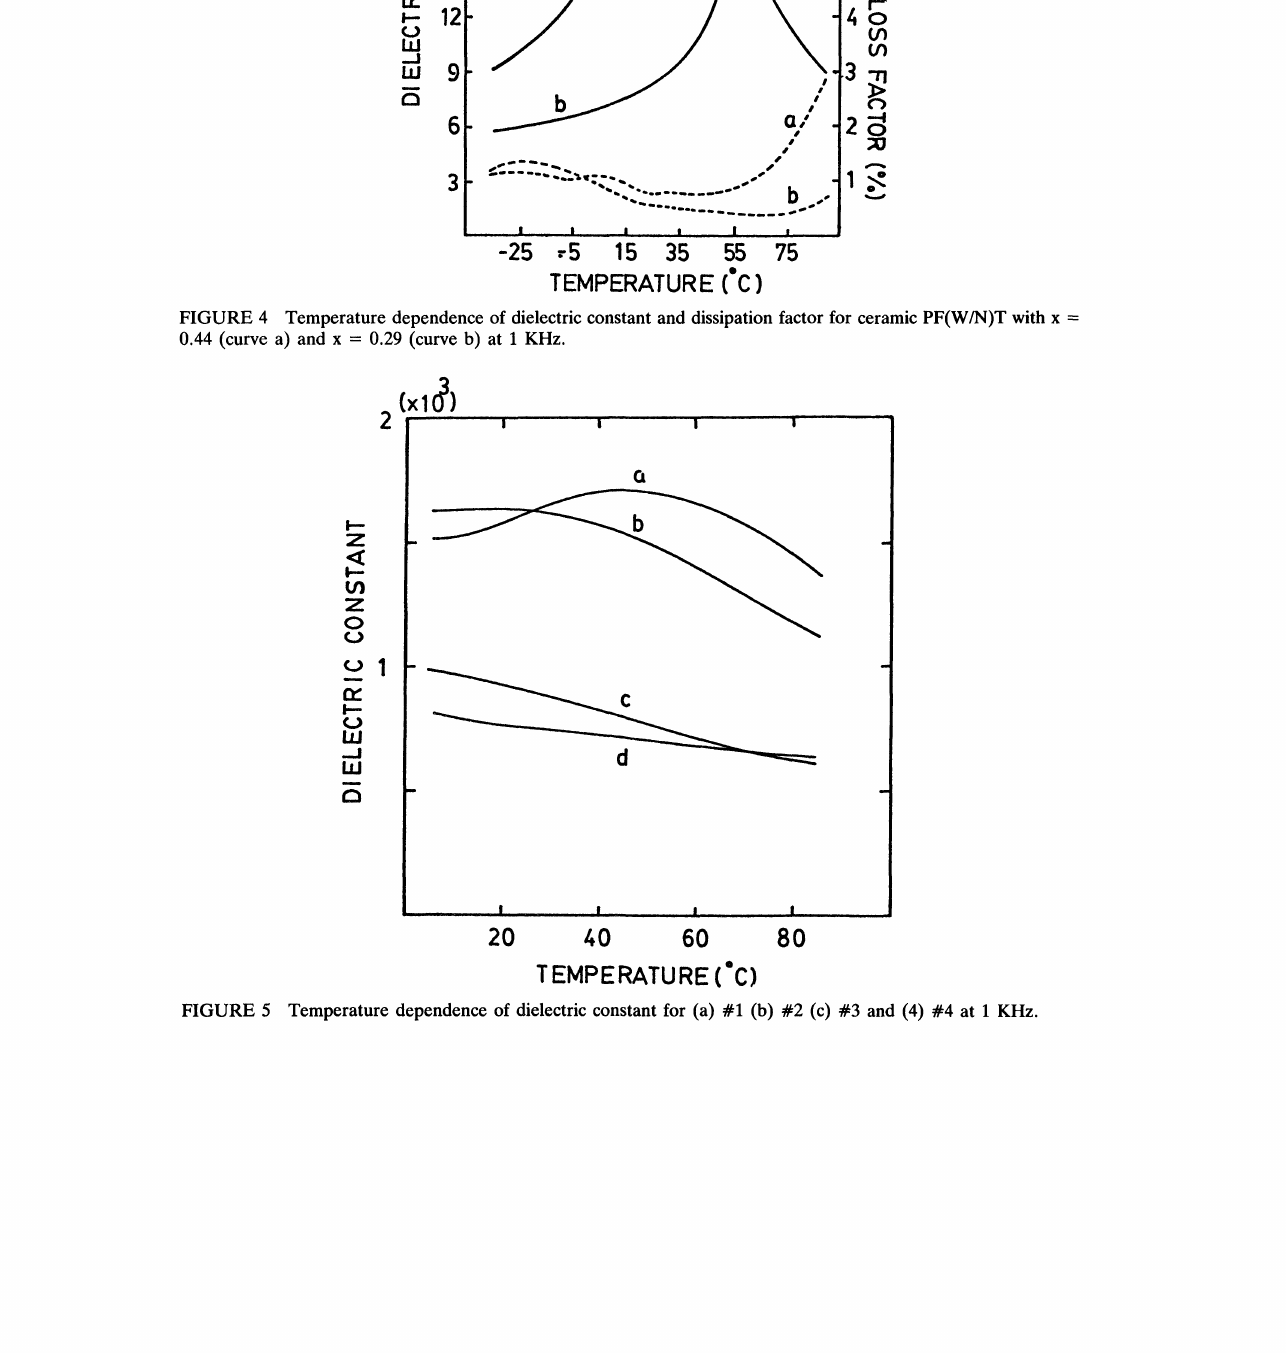
FIGURE 4 Temperature dependence of dielectric constant and dissipation factor for ceramic PF(W/N)T with x 0.44 (curve a) and x 0.29 (curve b) at KHz.